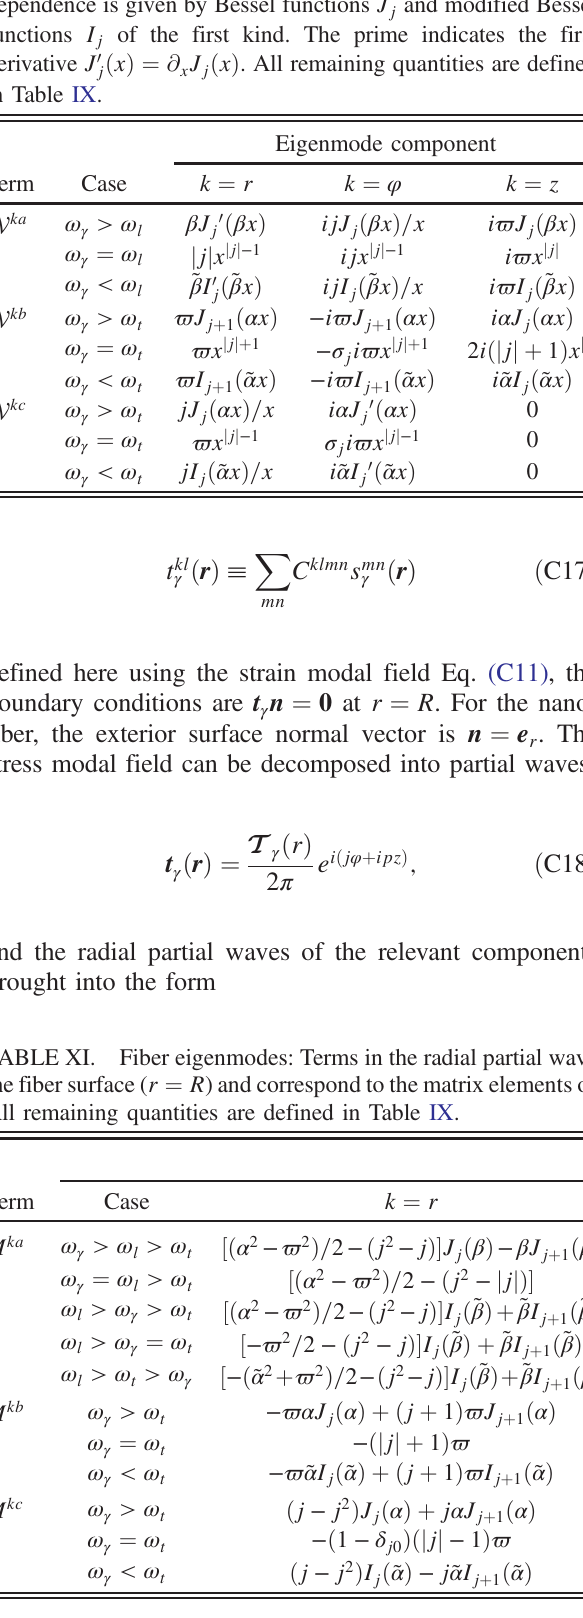
and modified Bessel j